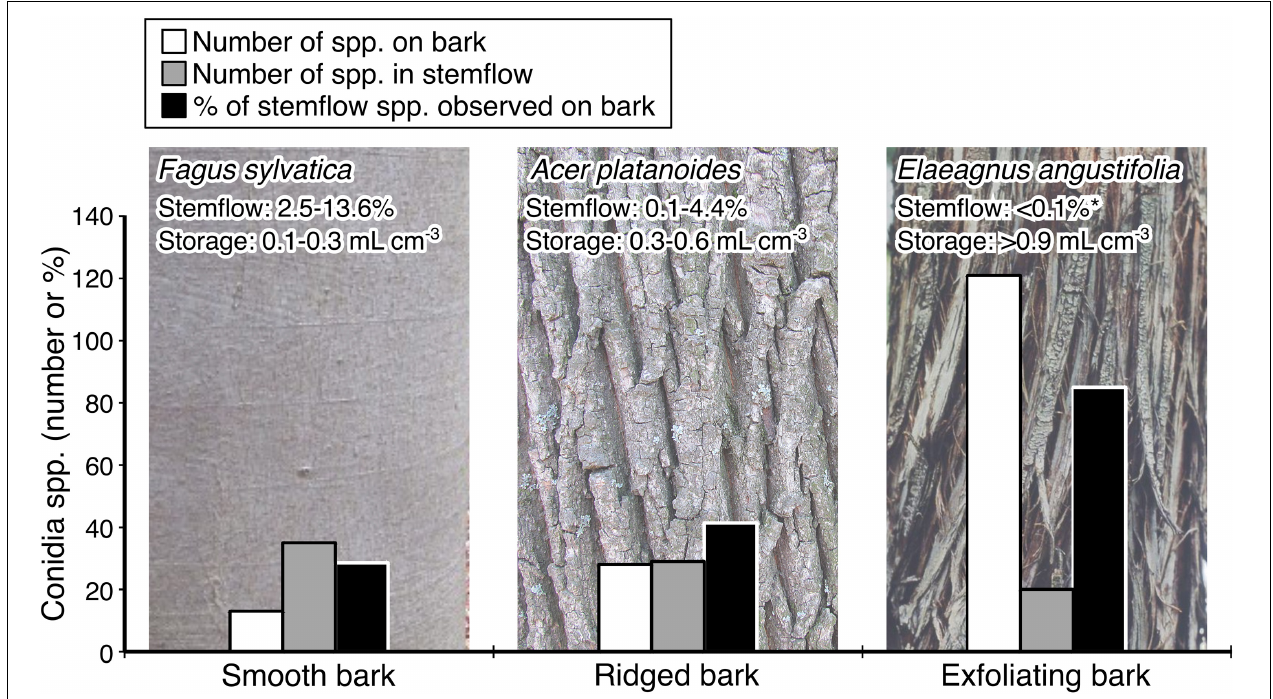
FIGURE 4 | A case study comparison of the number of species of conidia observed in bark (white bar) and stemflow (gray bar) assemblages between species with increasingly complex bark structure. Note that the portion of stemflow conidia species represented by species observed from bark (black bar) samples increases with bark complexity. Conidia data are from published studies (Gönczöl and Révay, 2006; Magyar, 2007, 2008; Révay and Gönczöl, 2011b). Include citations for stemflow and storage estimates. For context, observations of relative stemflow and normative bark water storage capacity are provided: Fagus grandifolia (Giacomin and Trucchi, 1992; Krämer and Hölscher, 2009; Van Stan et al., 2016); Acer platanoides (Valová and Bieleszová, 2008; Schooling and Carlyle-Moses, 2015; Campellone, 2018); Elaeagnus angustifolia (Schooling and Carlyle-Moses, 2015). *Stemflow from E. angustifolia reaching this value only occurred for storms ≥ 10 mm event-1 (Schooling and Carlyle-Moses, 2015). Photographs are all under creative commons licenses: F. sylvatica (Elsner, 2012), A. platanoides bark (Gmihail, 2014), and E. angustifolia (T. Davis Sydnor,